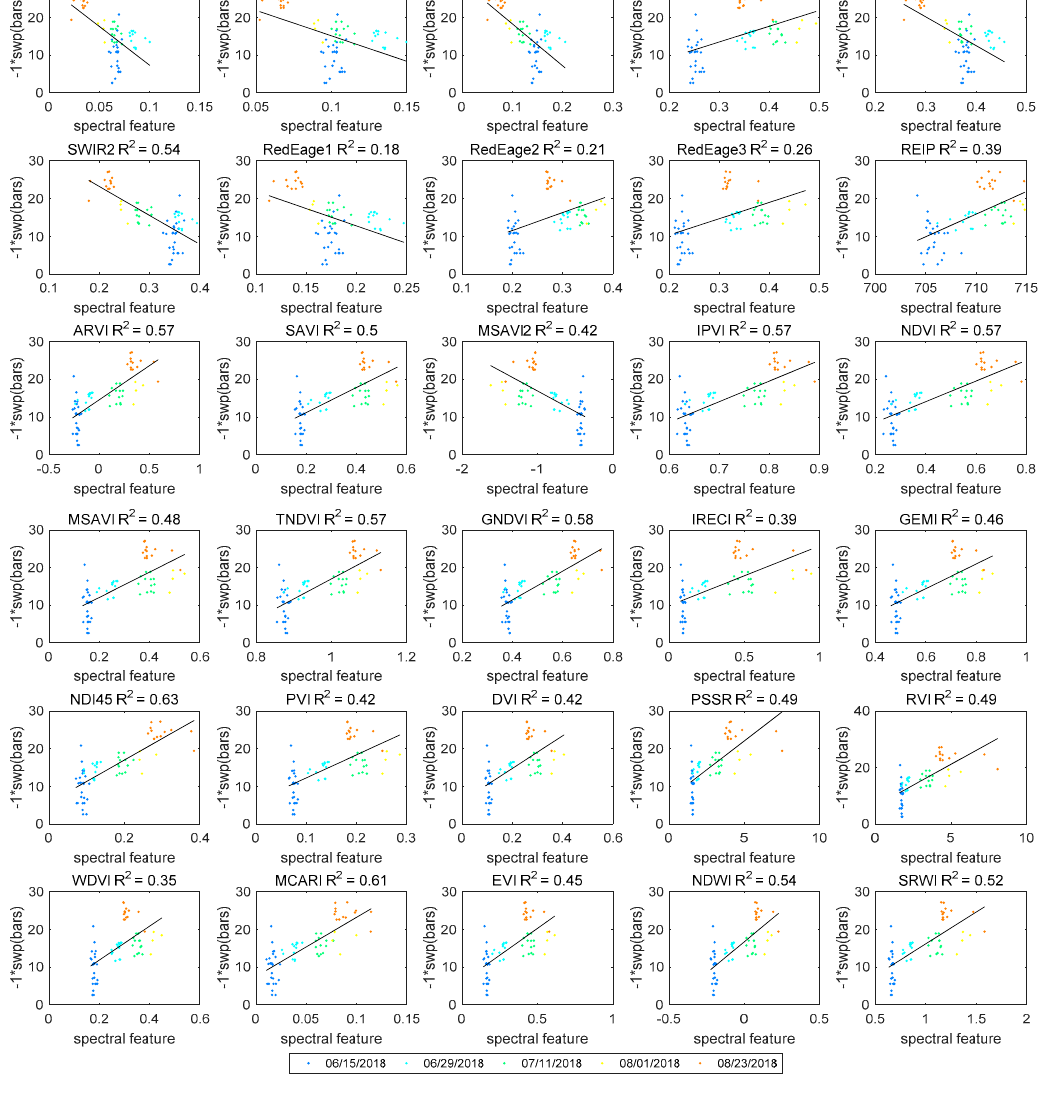
Figure 5. Relationship (R square) between midday stem water potential and vegetation indices in a ff erent colors indicate di ff erent dates during the cotton growing research field in Texas. Different colors indicate different dates during the cotton growing season. research field in Texas. Di